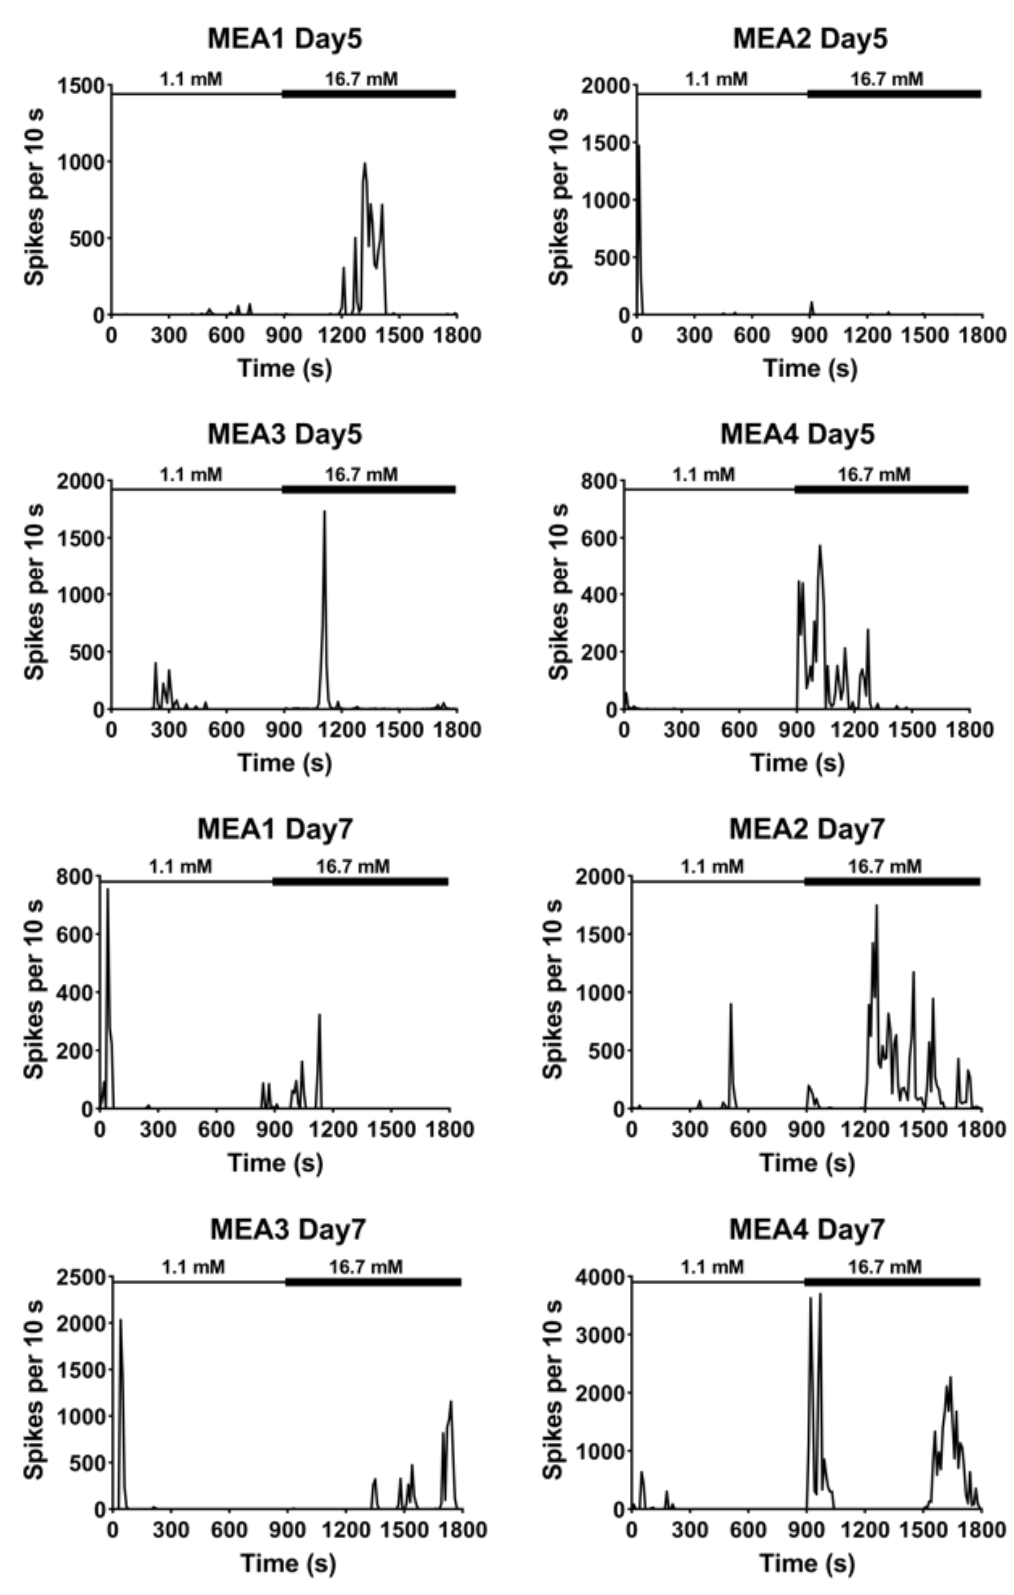
Figure 3. Total spiking with a bin size of 10 s for a total of 30 min recording. Each MEA was recorded with low glucose (1.1 mM) media for 900 s followed by another 900 s recording with high glucose (16.7 mM) media starting from day 1 post seeding until day 7. The number of spikes were summed every 10 s until the end of the